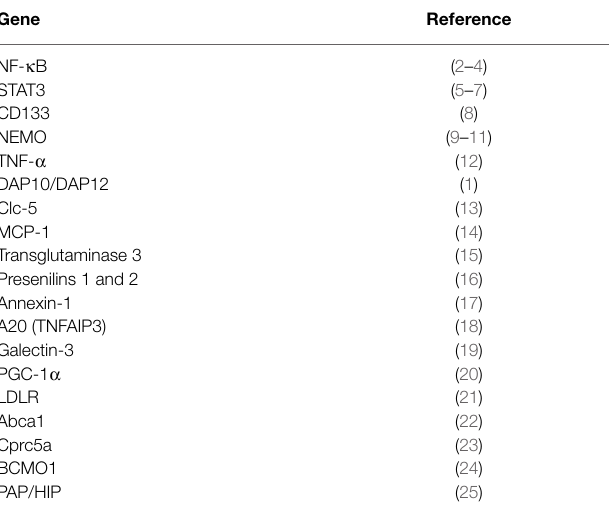
TABLE 1 | Heightened immune cell function and increased inflammation in a variety of gene knockout mice . Gene